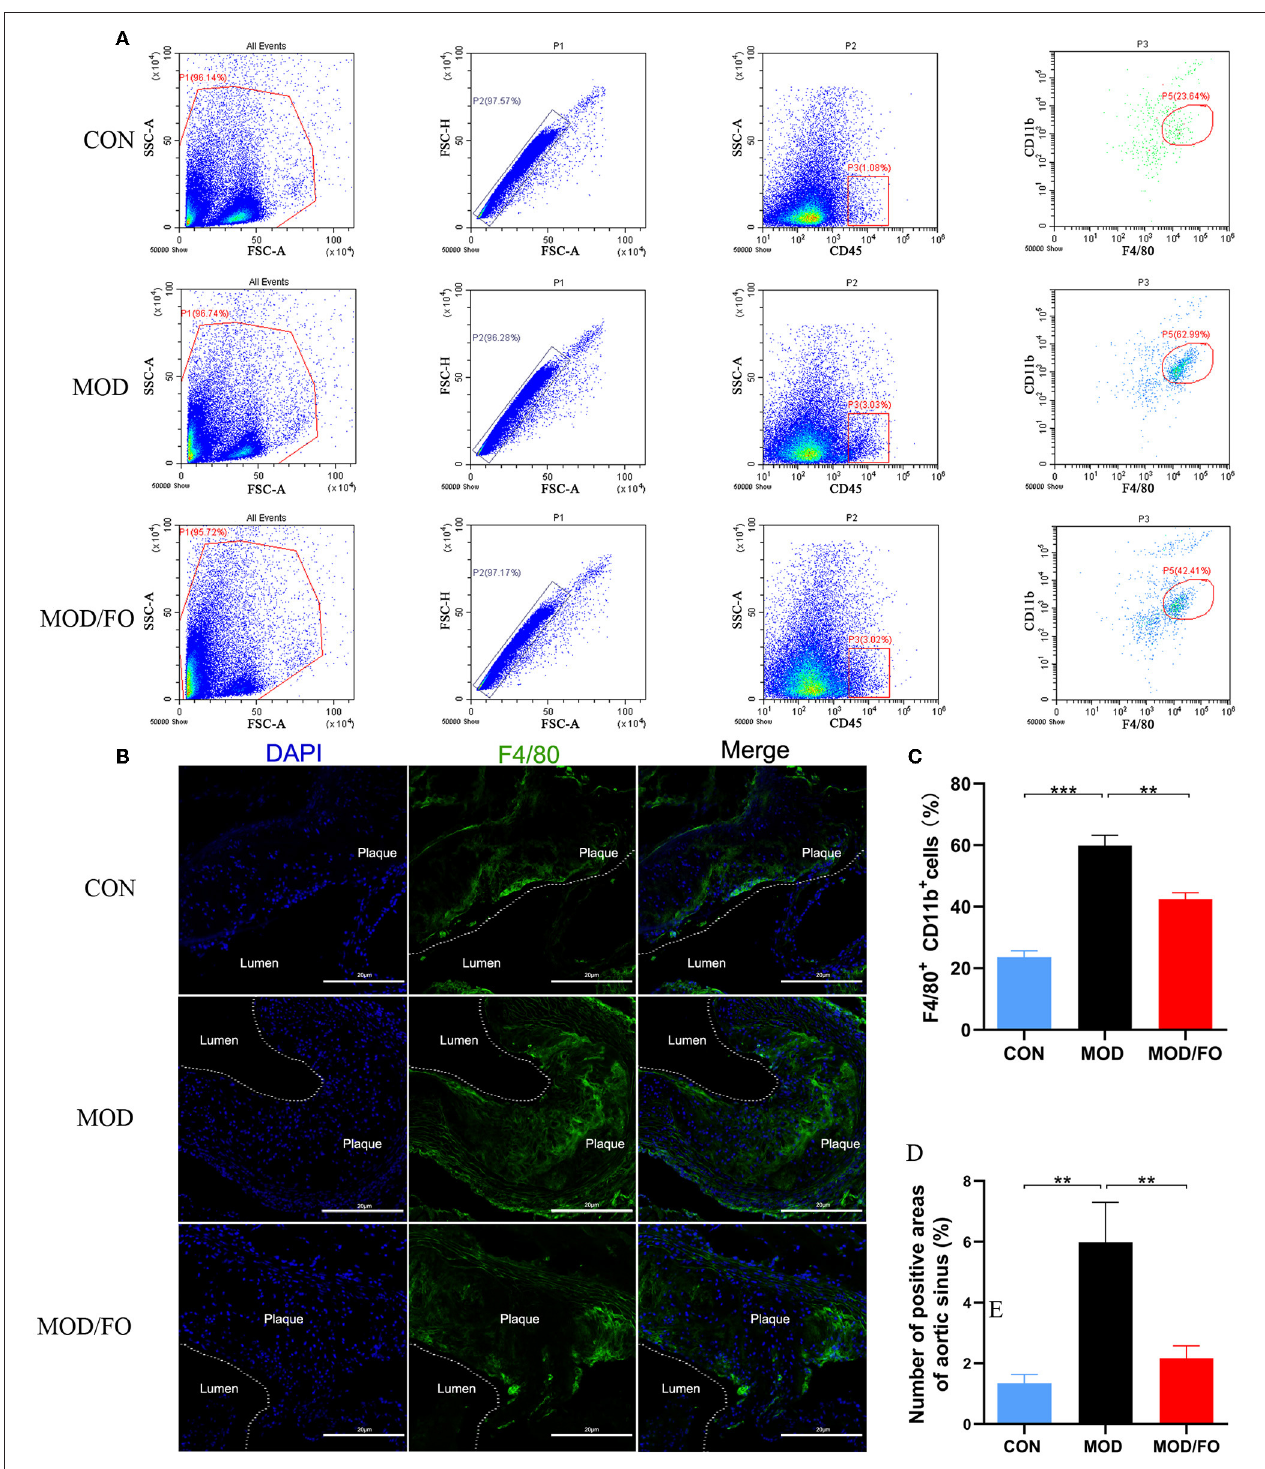
FIGURE 2 | ALA-rich FO inhibited inflammatory M ψ in atherosclerosis by flow cytometry and Immunofluorescence. After obtaining cell suspension from the aortic roots of atherosclerotic ApoE − / − mice, the M ψ stained by CD45 + , F4/80 + , and CD11b + were detected by flow cytometry. (A) Detection of M ψ by KO525 conjugated CD45 + , PE conjugated F4/80 + antibody, and FITC conjugated CD11b + antibody. (B) F4/80 + cells in immunofluorescence image. In flow cytometry, quantitative analysis as F4/80 + CD11b + cells (C) . In immunofluorescence assay, quantitative analysis as F4/80 + cells (D) . Values are given as mean ± SEM. ** P < 0.01, *** P <